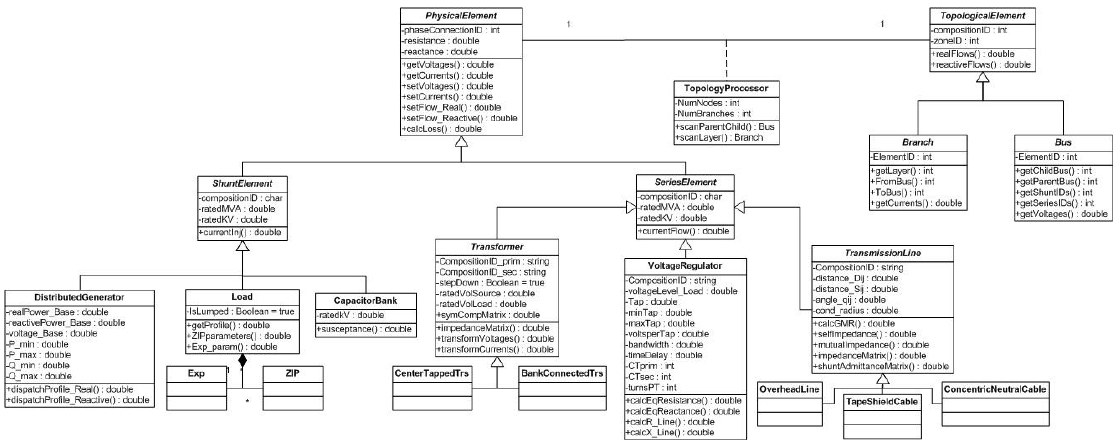
Figure 2. A simplified class diagram of the distribution system analysis framework.